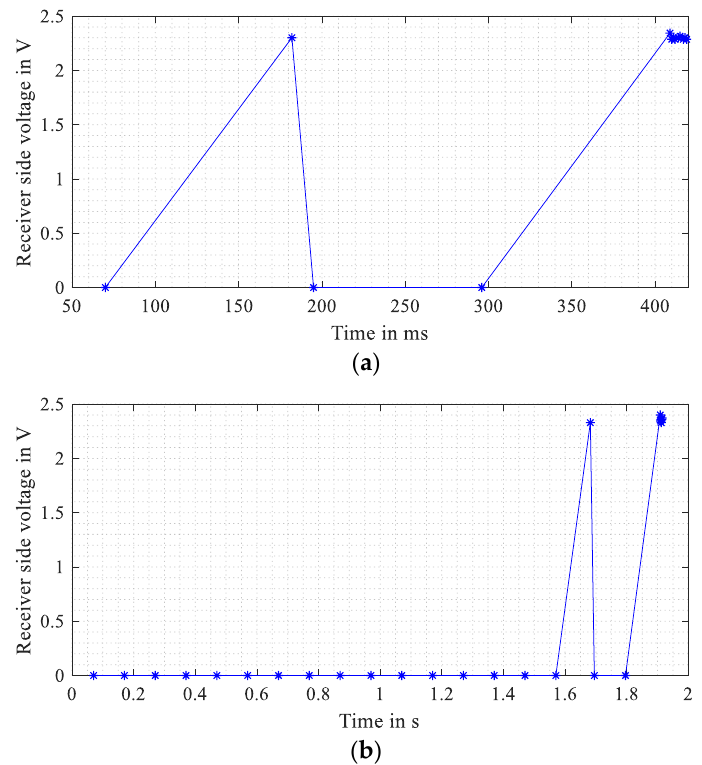
Figure 21. Receiving coil voltages measured by the WSN for different receiving coil positions: ( a ) On the top of C0, ( b ) On the top of C15.